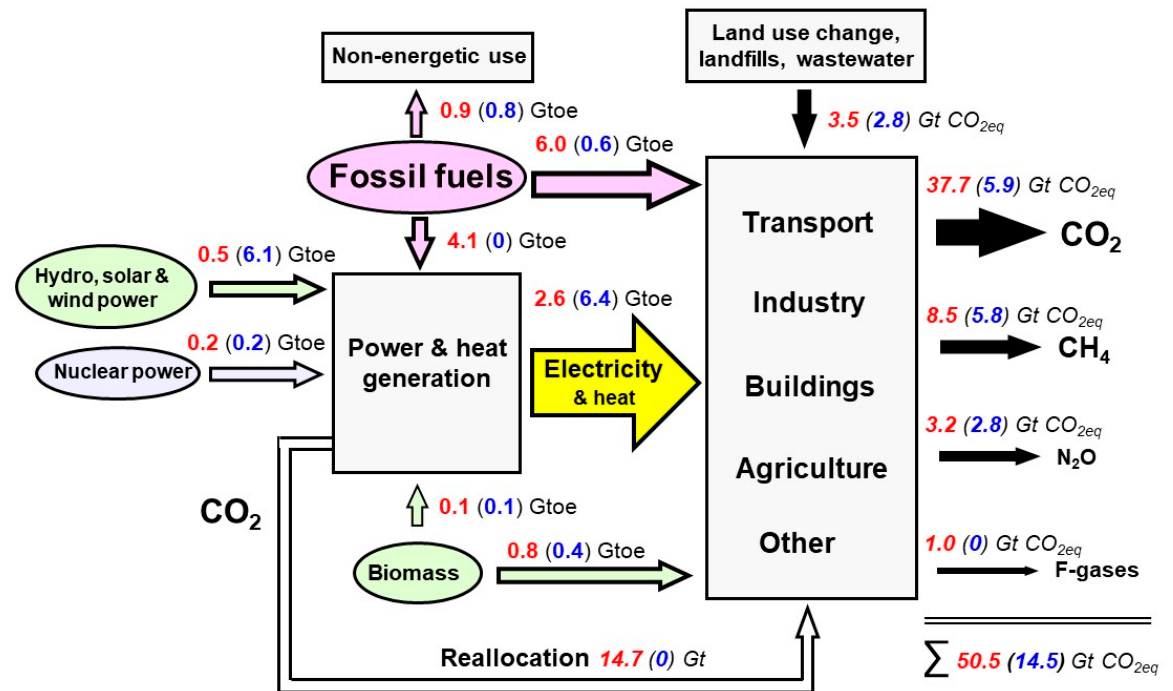
Figure 2. Simplified scheme of the model used to determine global greenhouse gas emissions. Consumption of fossil fuels and of electricity is also calculated. Numbers in red are for 2016 and in brackets (blue) calculated for 70% reduction of GHG emissions (measures 1 to 5 as discussed in detail in Section 4).